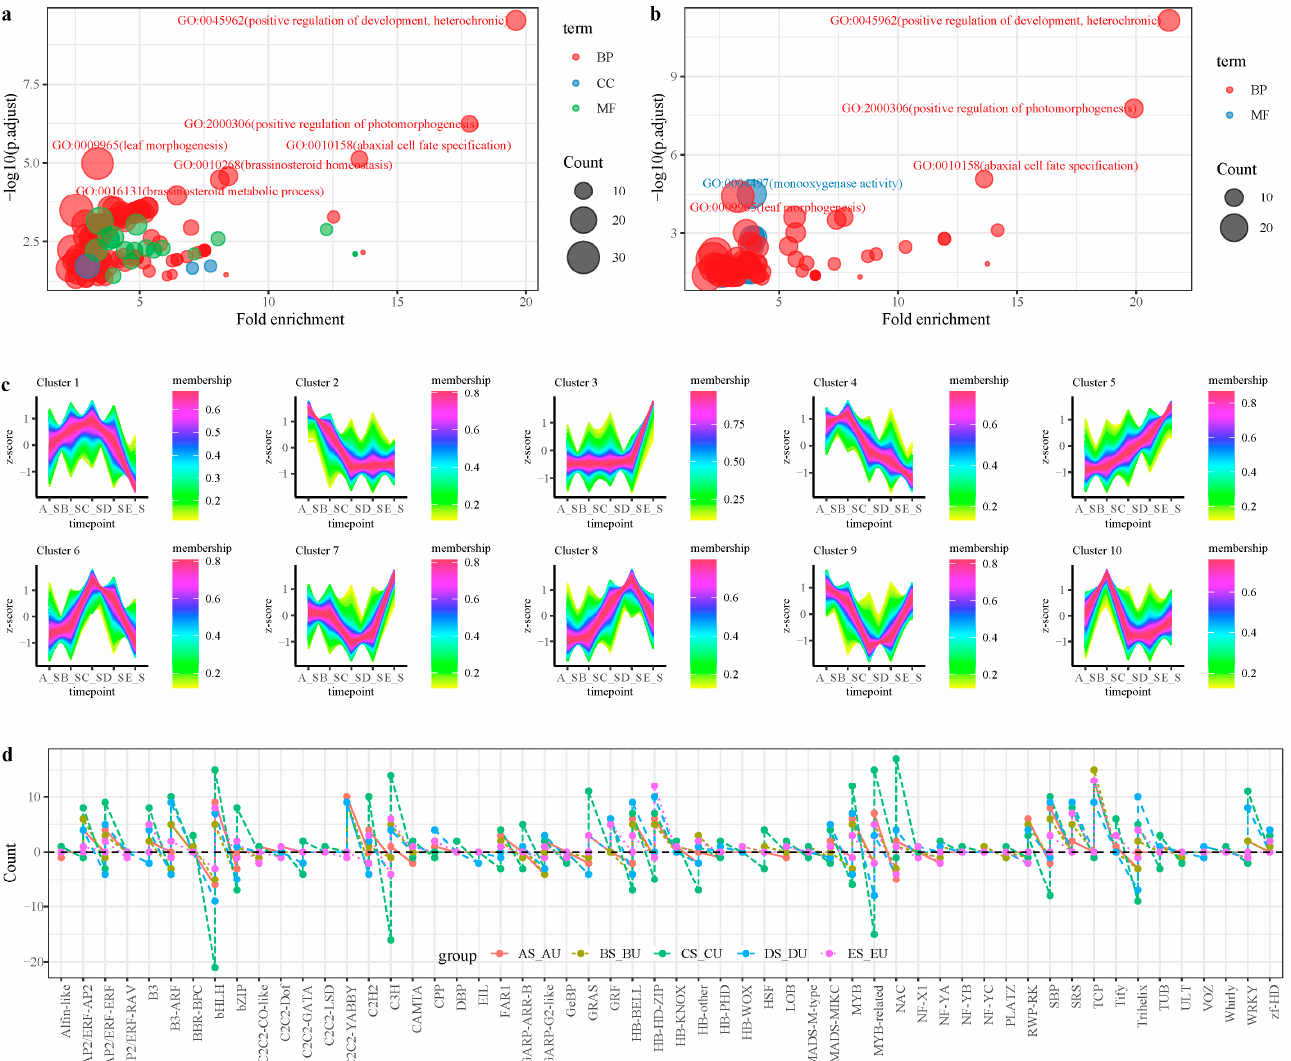
Figure 3. Sample PCA and correlation analysis. ( a ): GO enrichment analysis of DEGs in AS/AU group; ( b ): GO enrichment analysis of DEGs in BS/BU group; ( c ): Trend analysis of DEGs; ( d ): The differential expressed TFs in different group. Note: in ( a ), Fold enrichment = GeneRatio/BgRatio; in ( d ), the X -axis coordinates represent different TF families, the Y -axis represent the number of up-regulation or down-regulation, greater than 0 represents up-regulation number, and less than 0 represents down-regulation